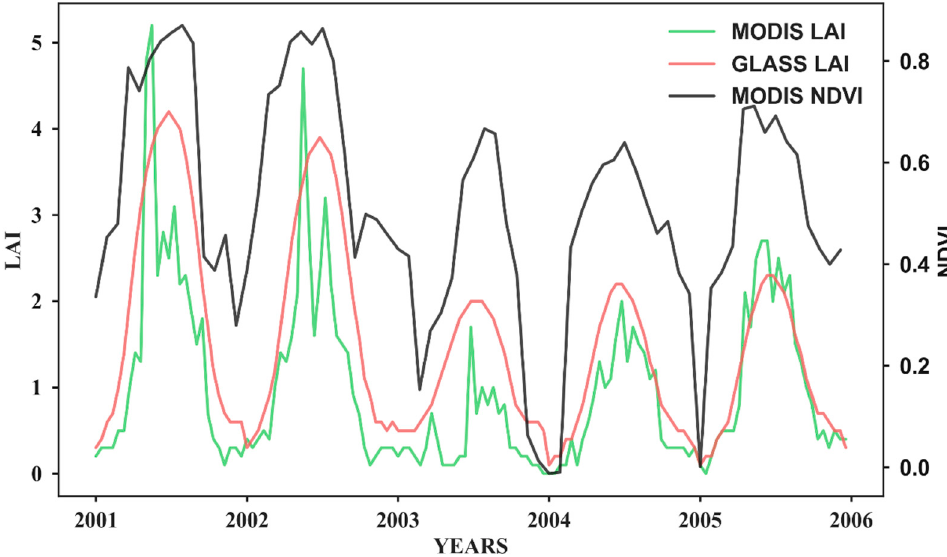
Figure 9. The time series curve of different products at the same location (3 × 3 km); GLASS LAI (red), MODIS LAI (green) and MODIS normalized difference vegetation index (NDVI) (black).